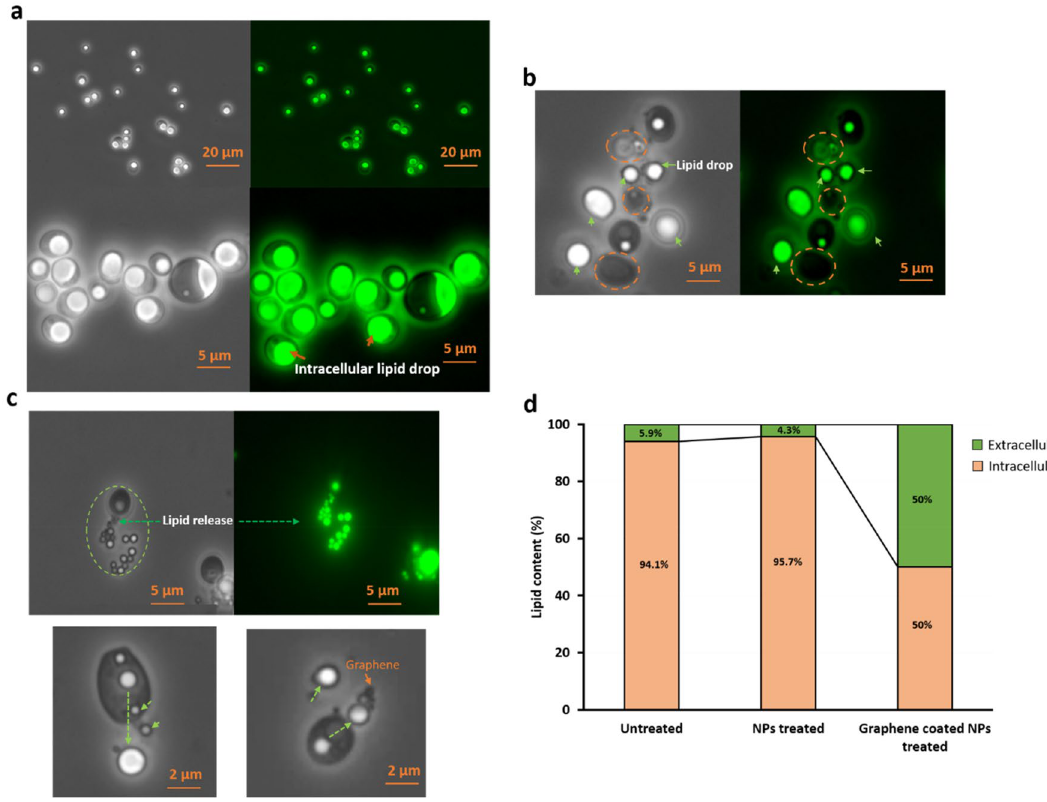
Figure 4. Bright field (left) and fluorescence (right) microscopic images of ( a ) untreated Y. lipolytica cells and ( b ) Y. lipolytica cells treated with graphene-coated nanoparticles. Samples were stained with BODIPY, which provides green fluorescence upon binding to lipids. The orange circles in the graphene-treated group show yeast cells with a complete release of intracellular lipid drops; green arrows are showing released lipid drops in the extracellular space. ( c ) Dropwise release of lipid droplets from yeast cells. The green circle is showing dropwise release (green arrow) and extracellular accumulation of lipid droplets. Zoomed-in images (bottom panels) show the interaction of graphene-coated nanoparticles and lipid drops, and their stepwise release from yeast cells. The green arrows show released lipid droplets and orange arrows indicate graphene-coated nanoparticles. ( d ) Quantification of intracellular and extracellular lipids, stained with BODIPY, in control and graphene-treated samples. Cumulative data obtained by examination of 200 untreated and 200 treated